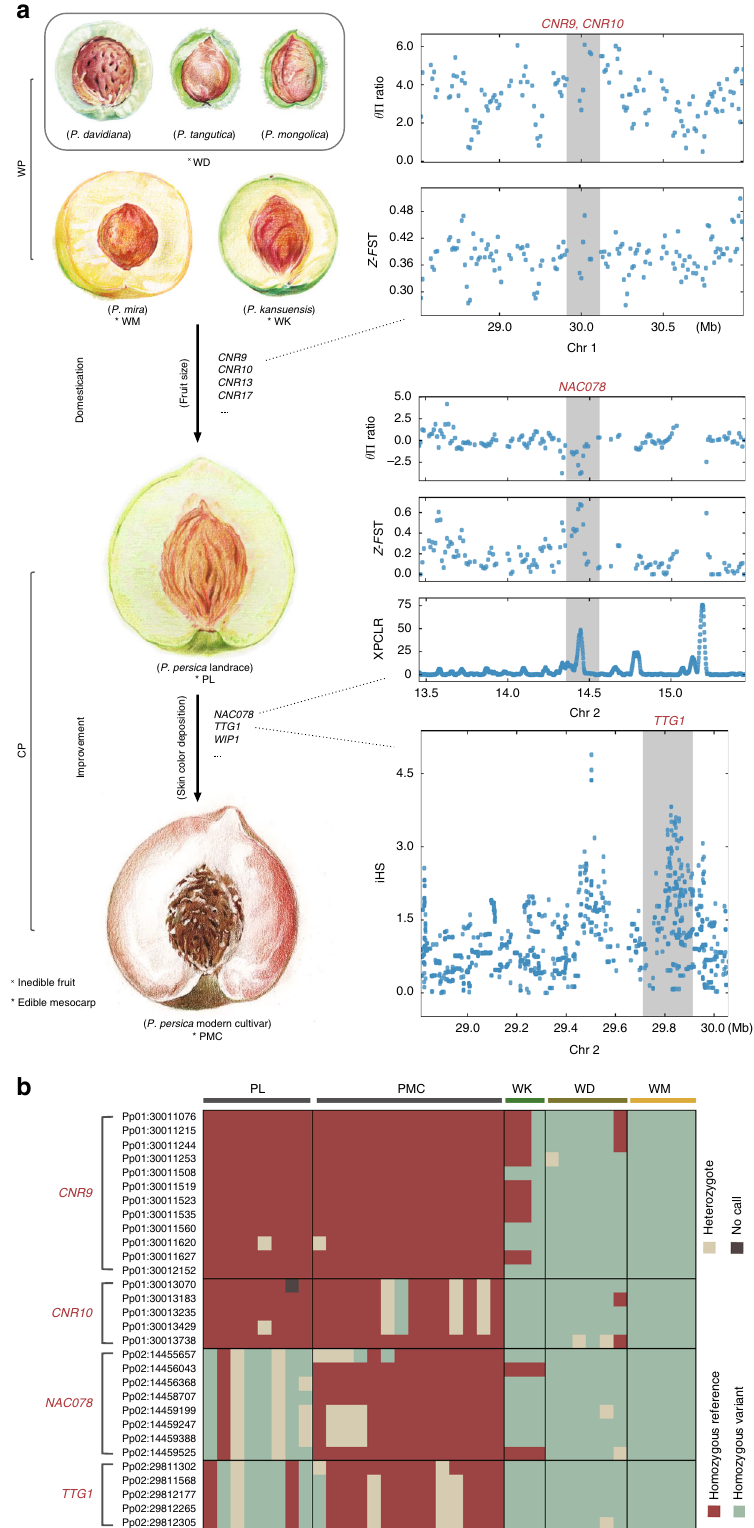
Fig. 6 Stage-wise selection for fruit size and skin color during peach domestication and improvement. a Schematics of fruit evolution during peach domestication. Several candidate genes underlying peach fruit size and skin color were shown, and of these genes, CNR9 , CNR10 , NAC078 , and TTG1 within regions having positive selection signatures were visualized with gray shadows in Manhattan plots. Fruit images were created by Yang Yu and Shan Gao. b Haplotype differentiation patterns of CNR9 , CNR10 , NAC078 , and TTG1 . Across the PL, PMC, WK, WD, and WM accessions, signi fi cant haplotype differentiation patterns were observed for several SNPs within these several candidate genes related to fruit size ( CNR9 and CNR10 ) and skin color ( NAC078 and TTG1 ). The haplotype differentiation patterns were further con fi rmed using the peach genome data from Cao et al. 8 (Supplementary Fig.